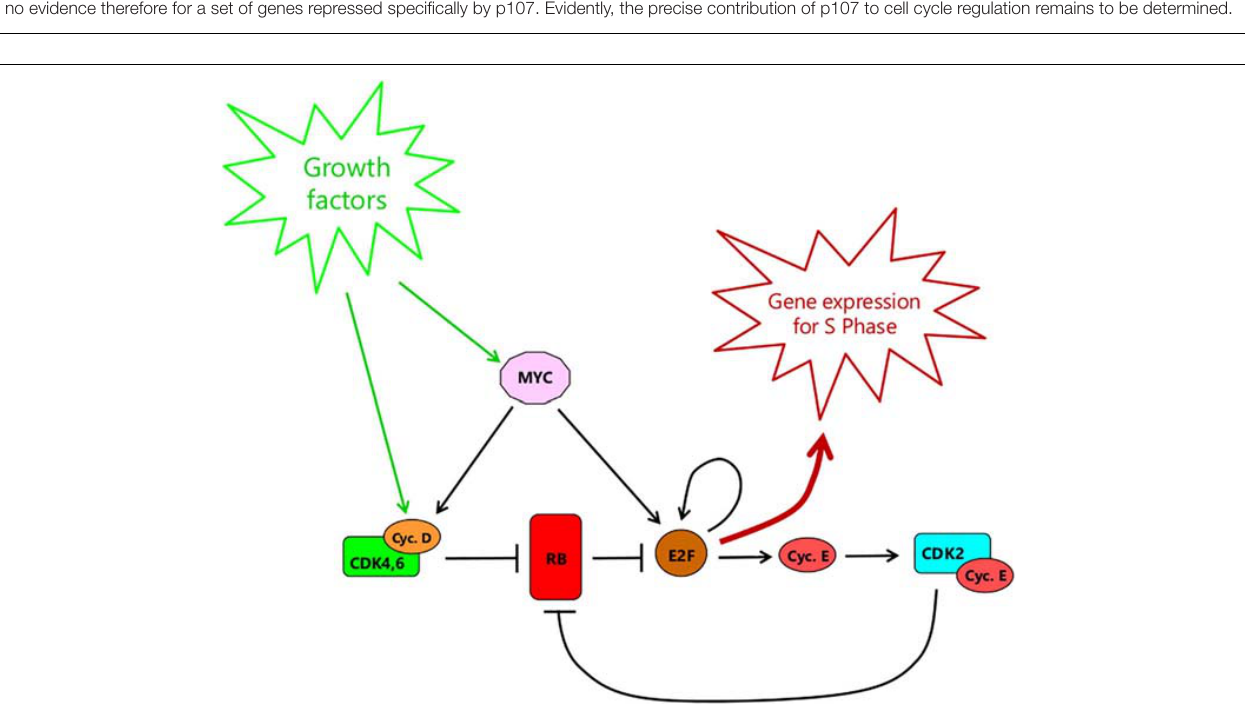
Frontiers in Cell and Developmental Biology |